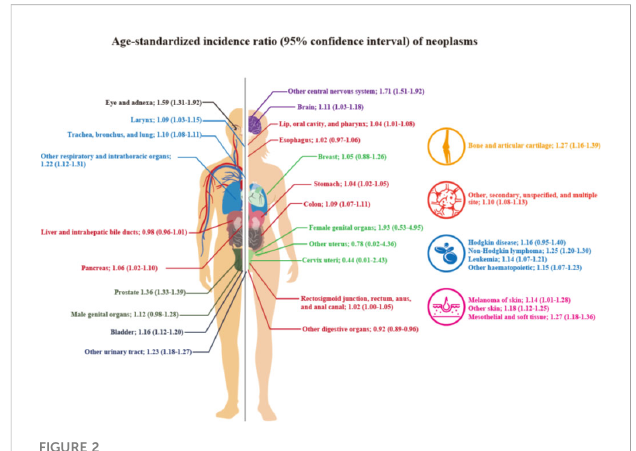
FIGURE 2 SIRs and 95% CIs according to the sites of the